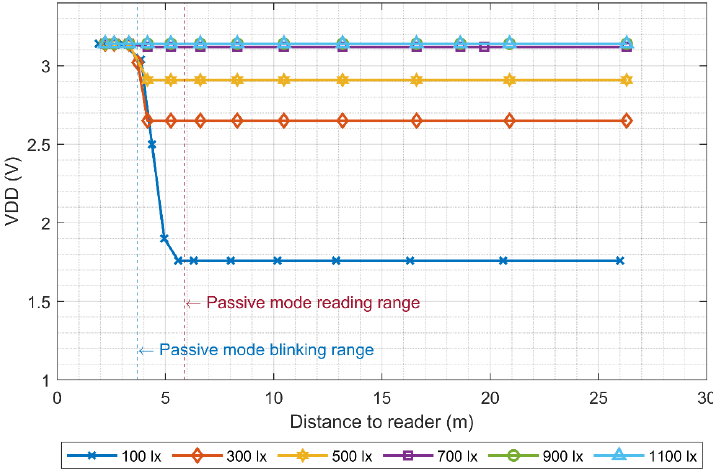
Figure 15. Supply voltage of the RFID tag as a function of the distance to the reader, for various illuminance